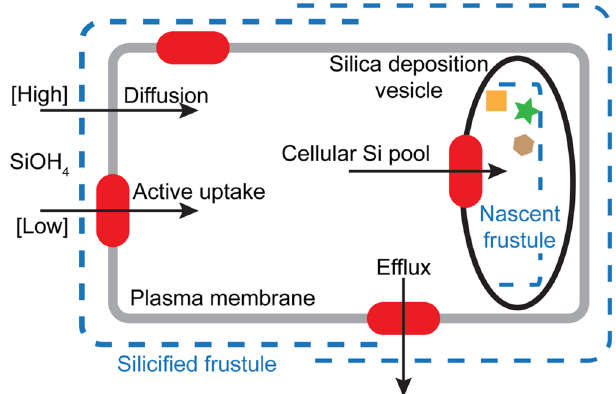
Figure 1. Schematic cartoon of silica formation in the diatom. Soluble silicic acid enters the diatom cell through active or passive transport and is moved to the silica deposition vesicle (SDV) via intracellular Si pools. The SDV is the site of frustule synthesis and the nascent frustule forms in the presence of various biomolecules, shown here as geometric shapes. See text for